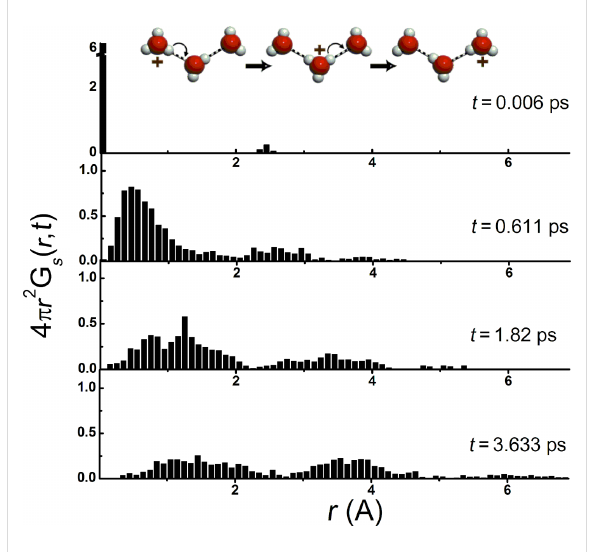
Figure 16: The G s ( r , t ) correlation function is the time-dependent conditional probability density that a particle (charge) moves a dis- tance r = | r (0) − r ( t )| during time t . At t = 0, G s ( r ,0) = δ ( r ), whereas in the long time limit, the system looses memory of the initial configur- ation and G s ( r ,0) becomes independent of the distance r : where V is the system